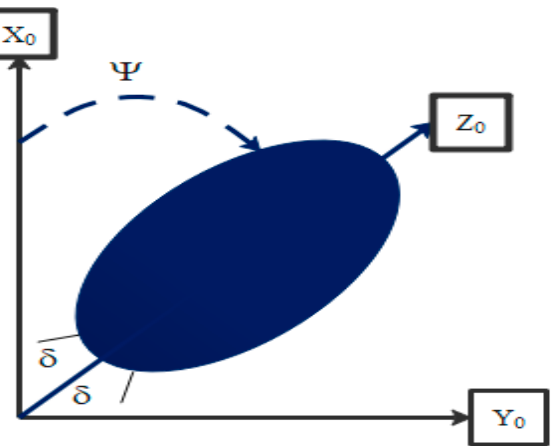
Figure 2. Heading plane motion of the autonomous underwater vehicle.